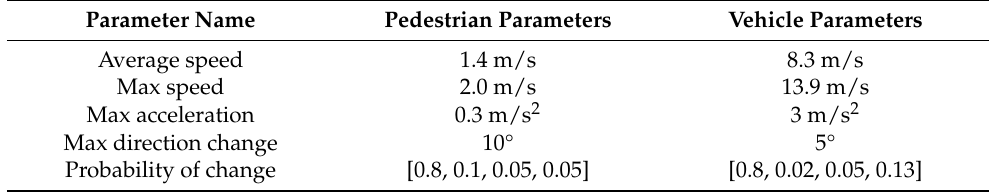
Table 1. The parameters of our simulation